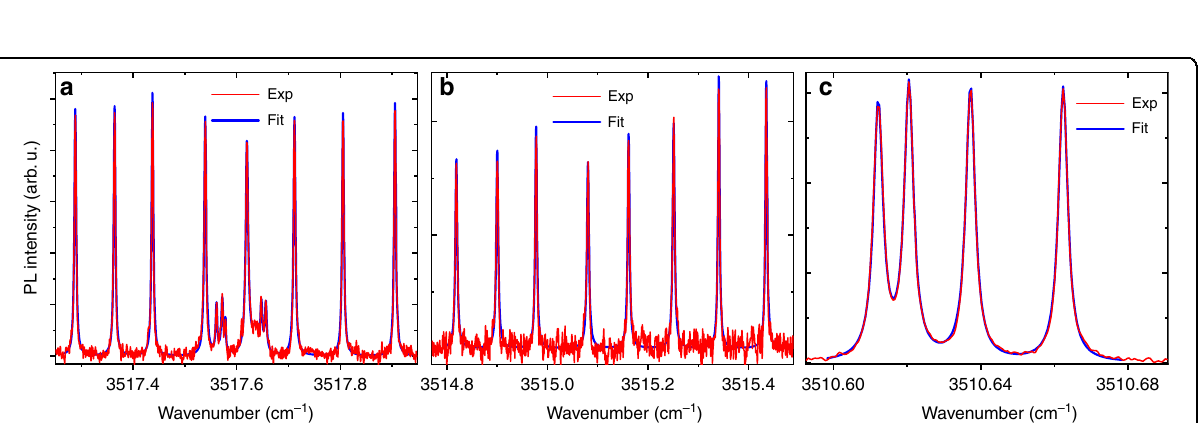
Fig. 4 Hyper fi ne structure of several photoluminescence lines in the 5 I 6 → 5 I 7 transition of Ho 3 + : 7 LiYF 4 at T = 6 K. Lines correspond to the transitions a 2 → 2 [ 5 I 6 Г 1 (8673.4) → 5 I 7 Г 34 (5155.75)] and 3 → 3 [ 5 I 6 Г 34 (8680.3) → 5 I 7 Г 1 (5162.8)]; b 1 → 2 [ 5 I 6 Г 2 (8670.9) → 5 I 7 Г 34 (5155.75)]; c 2 → 3 [ 5 I 6 Г 1 (8673.4) → 5 I 7 Г 1 (5162.8)]. Red traces are experimental spectra registered with δσ = 0.001 cm − 1 , blue curves represent the results of fi t with sets of Loretzians. Note the stretched wavenumber scale at c